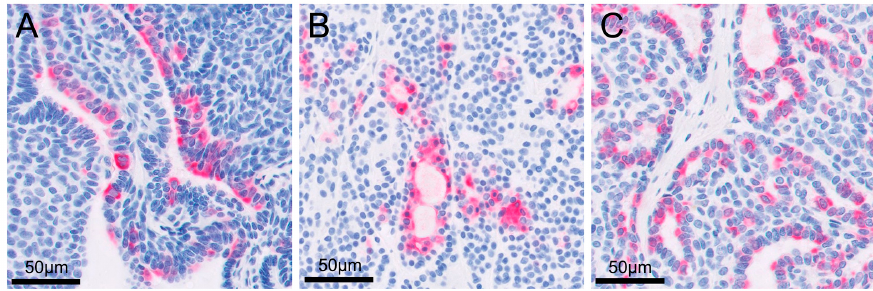
Figure 5. High magnification images of immunohistochemistry to show cytokeratin 7 positivity in the cytoplasm of the cells: ( A ) right metatarsal skin mass; ( B ) metastatic retroperitoneal mass; ( C ) enlarged right popliteal lymph node.